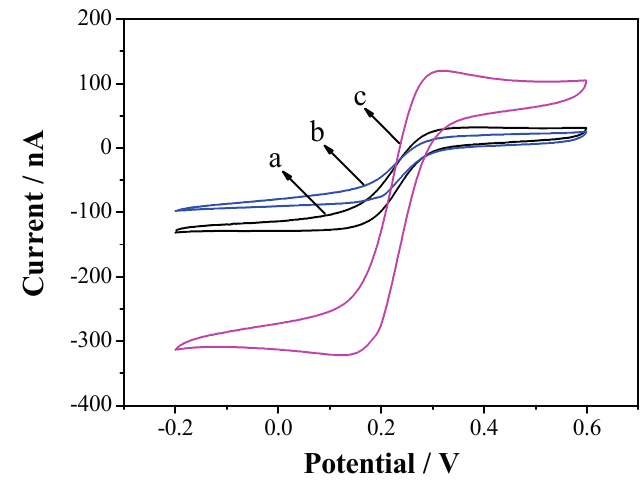
Figure 5. CV curves of bare UMEA (a), GN-COOH/UMEA (b) and rGN-COOH/UMEA (c) in 0.5 mM Fe(CN) 63 − solution.